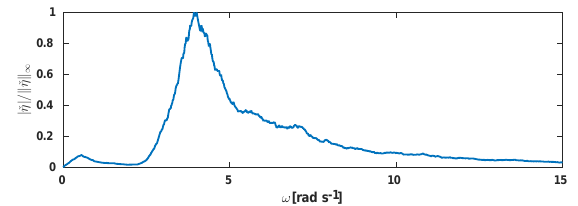
Figure 21. The same as Fig. 7; now for the case